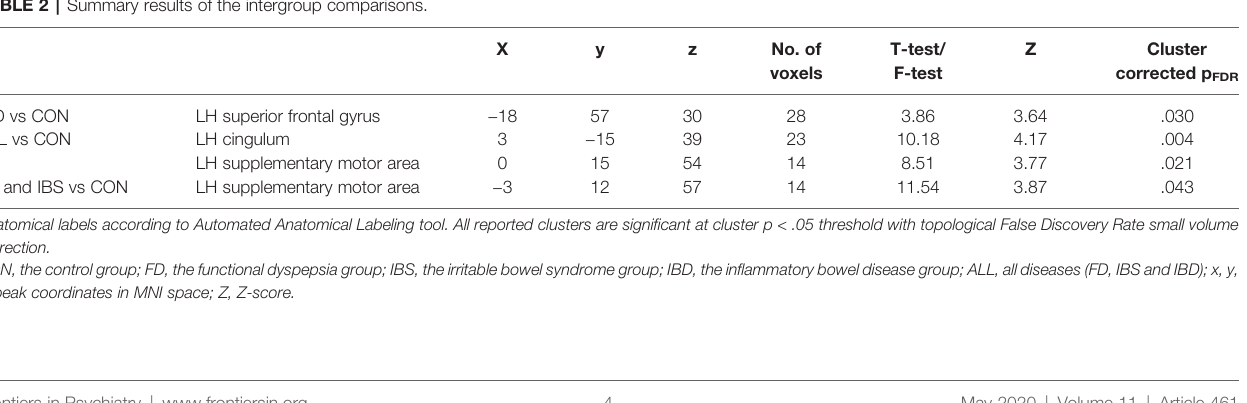
TABLE 2 | Summary results of the intergroup comparisons.